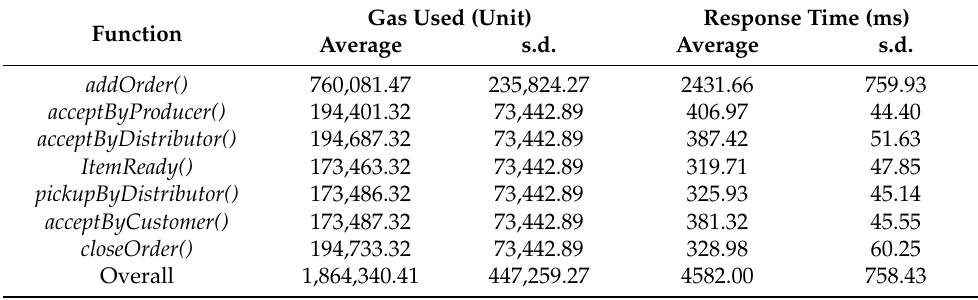
Table 3. Average gas used and response time for each